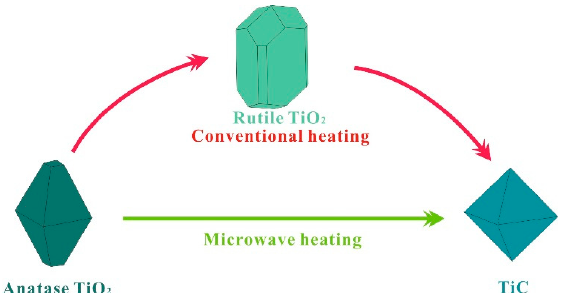
Figure 1. Schematic of different reaction routes between conventional and microwave heating.